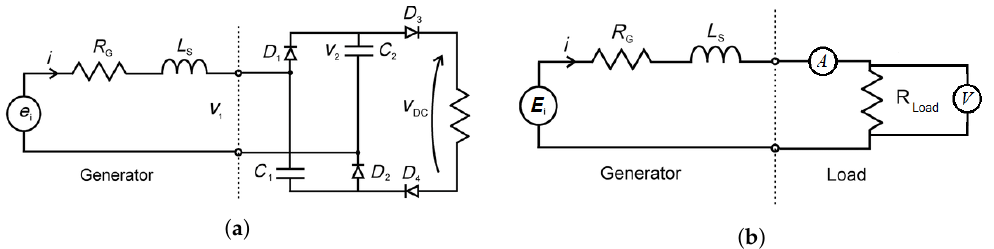
Figure 5. Single-phase electrical circuits for the generator connected to the resonance-rectifier [37] ( a ) and the experimental setup ( b ). E i is induced voltage; i is current; R G is the generator’s internal resistance; L s is the inductance of the generator; R load is the resistive dump load during the measurements; A is the current meter; V is the voltage meter; V 1 is the voltage over the generator; D 1 to D 4 are diodes; C 1 and C 2 are capacitors; V 2 is the voltage over capacitor 2; V DC is the